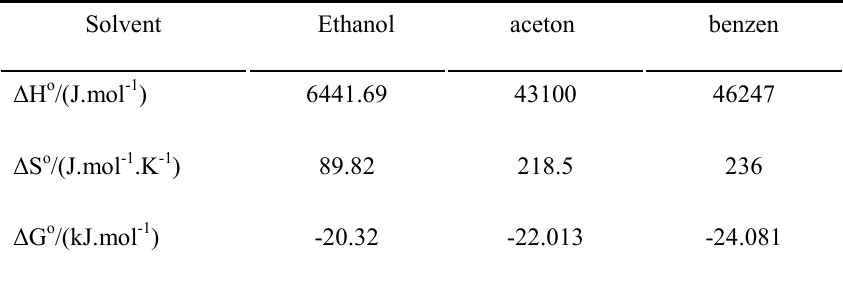
Table 2. Thermodynamic Parameter Values for cis-[Pt( p -Tol) C H NO at various temperatures in ethanol, acetone and benzene at 5 5